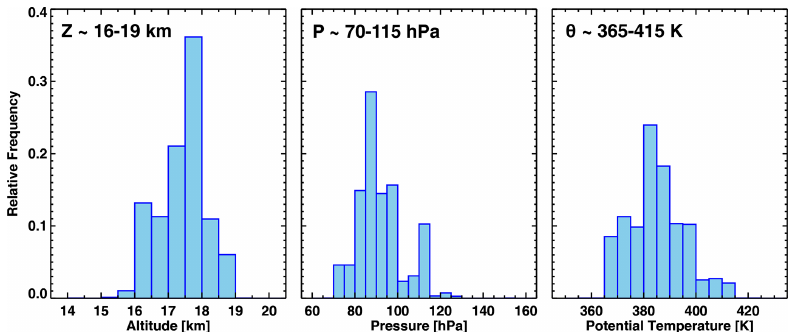
Figure 6. Relative frequency distributions of transition layer measurements in altitude, pressure and θ